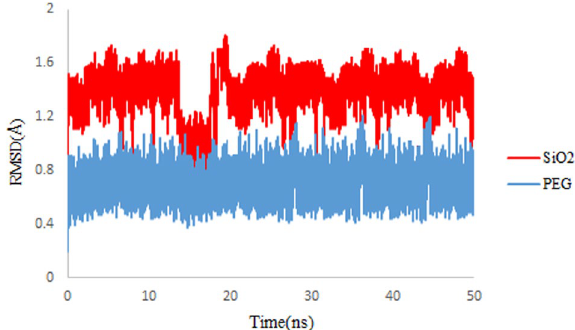
Figure 3. RMSD values of 3TC on SiO 2 (red) and 3TC on PEG (blue) complexes during 50 ns simulation.